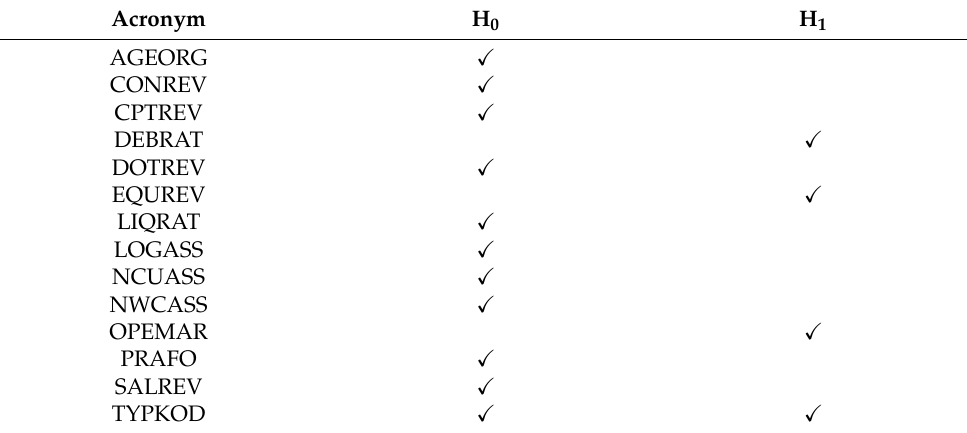
Table 12. Hypothesis